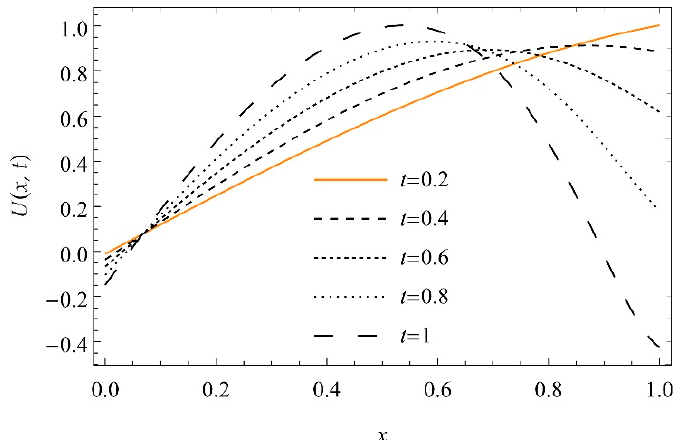
Figure 15. The graph of 𝑈(𝑥,𝑡) versus depth 𝑥𝑛 = 1, 𝛼 = 1 , and for 𝑡 = 0.2,0.4, 0.6, 0.8,1 for